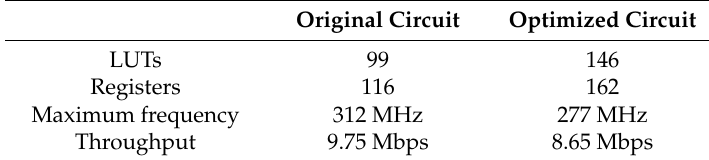
Table 3. Resource utilization and performance report of original and optimized SIMON